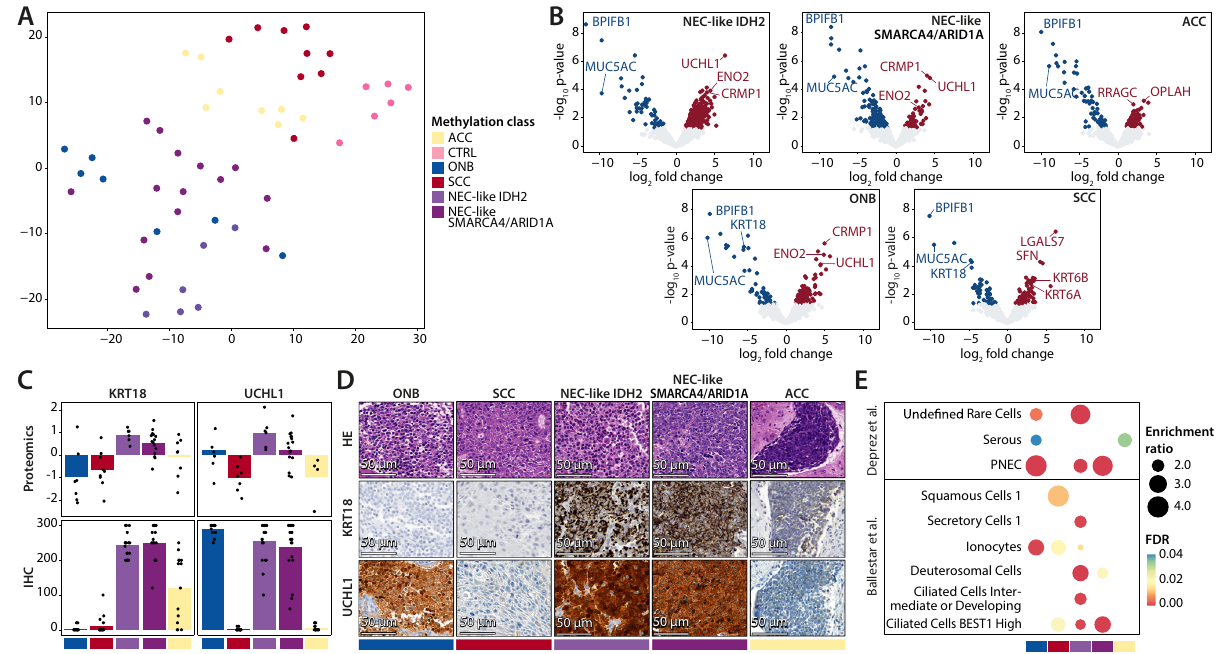
Fig.3|Resultsfrommassspectrometry-basedproteomics.A t-SNEdepictingthe global proteomic pro fi le correlation between normal sinonasal tissue (CTRL), olfactory neuroblastoma (ONB), sinonasal squamous cell carcinoma (SCC), NEC- like IDH2, NEC-like SMARCA4/ARID1A, and adenoid cystic carcinoma (ACC). ONB, NEC-like IDH2 and NEC-like SMARCA4/ARID1A had an unexpectedly similar pro- teomic pro fi le. B Differential expression analysis between normal sinonasal